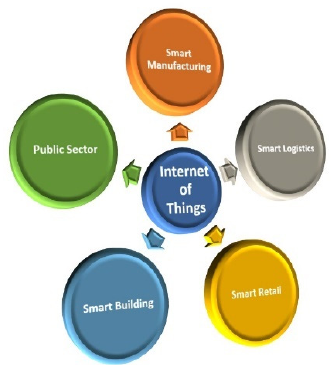
Figure 2. IoT and fields where can be